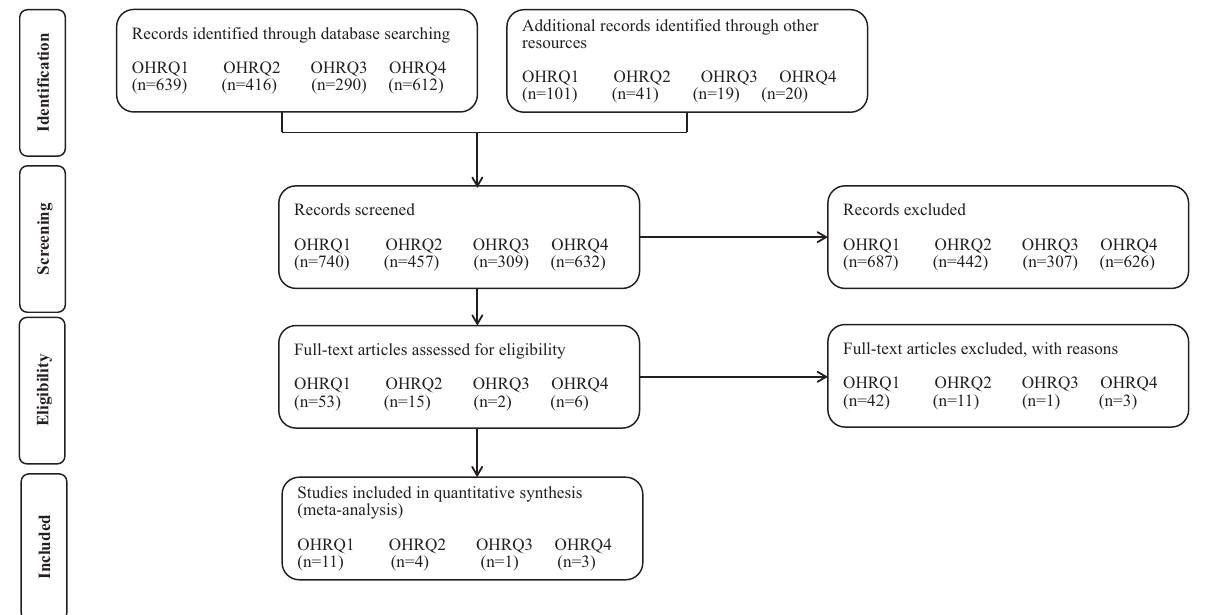
Fi g ure 1 P RISMA flo w